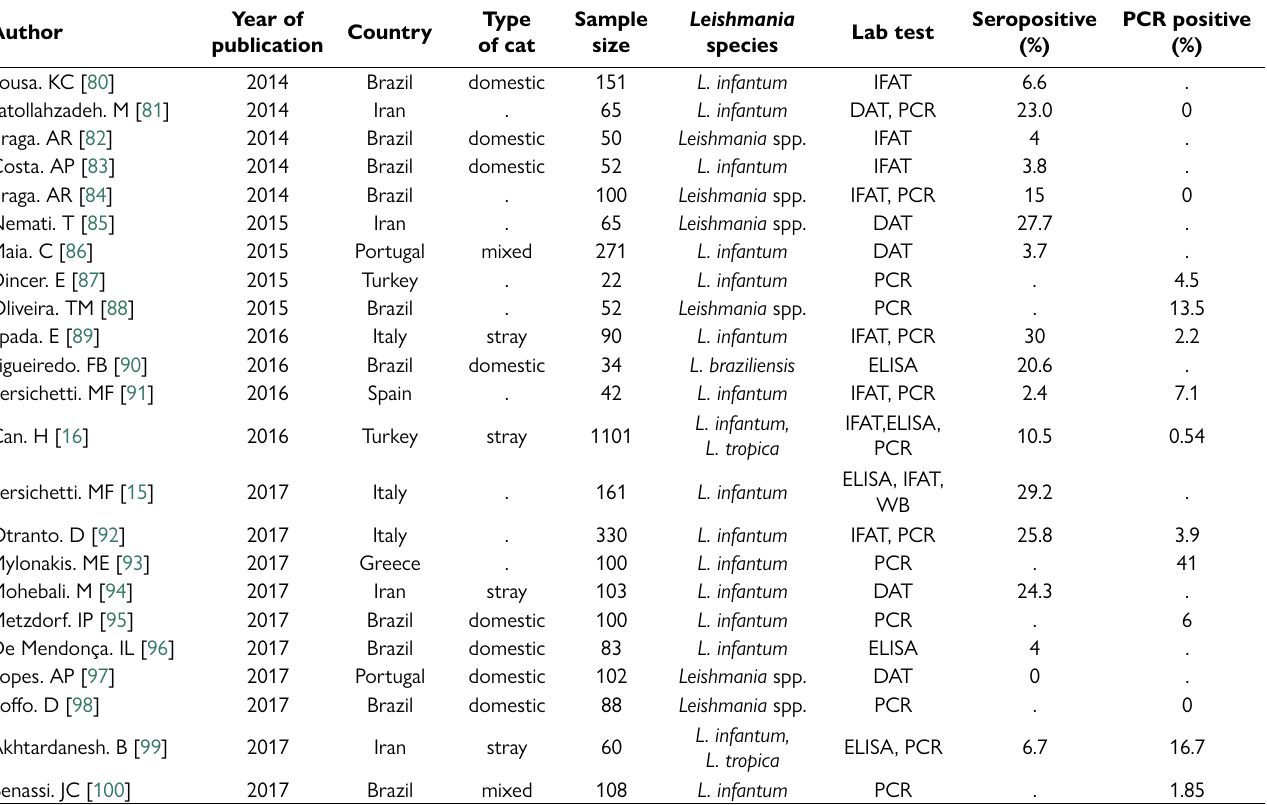
Table 2. Subgroup meta-analysis for seroprevalence and PCR prevalence of Leishmania infection in cats Characteristics